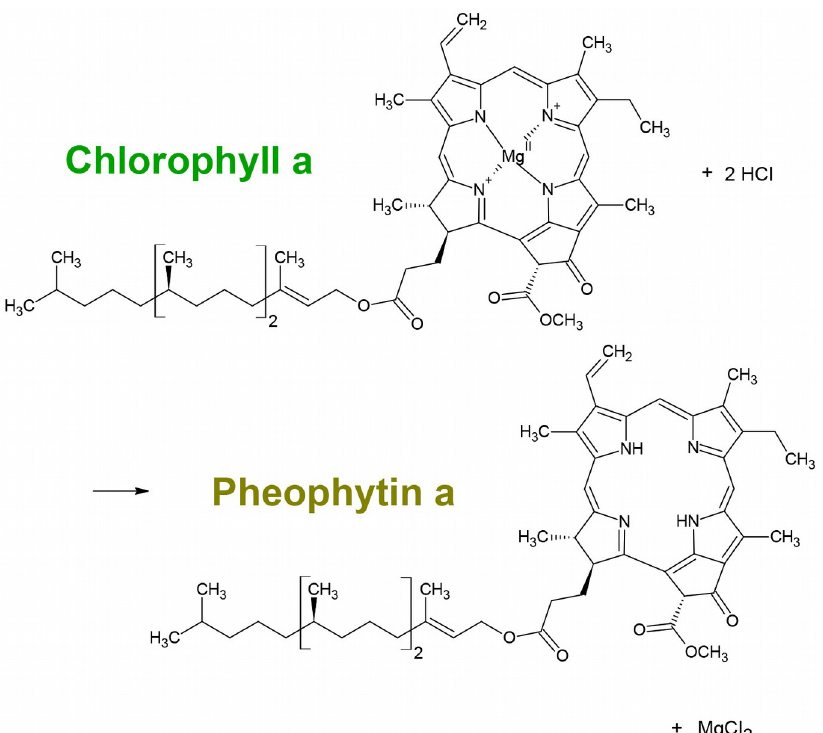
Figure 4. Reaction scheme of hydrogen chloride effect from burned PVC on chlorophyll